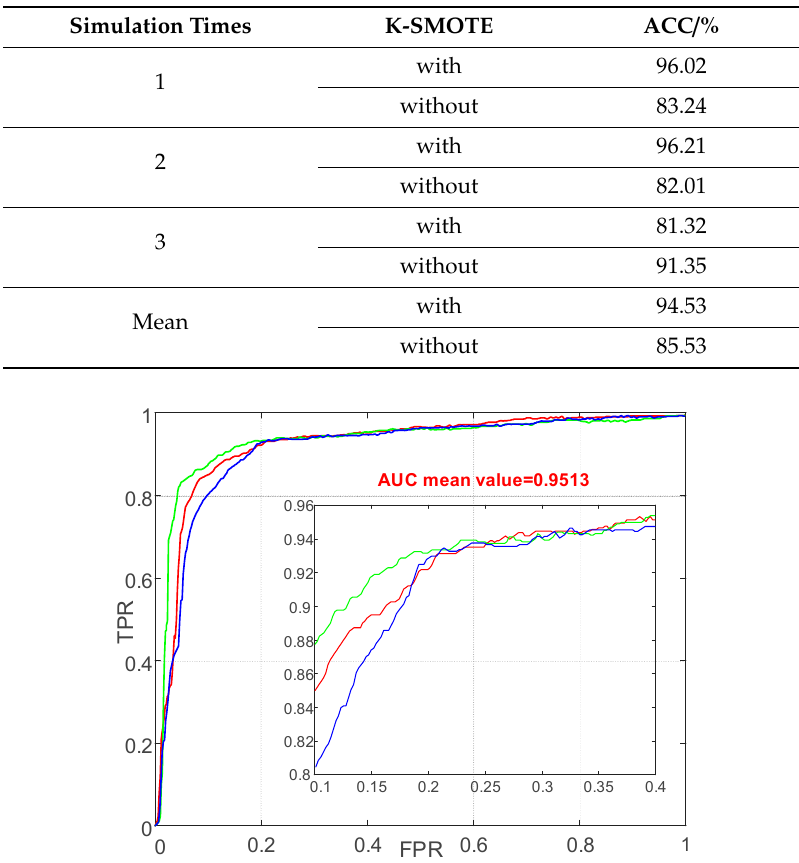
Figure 7. Receiver operating characteristic curve detected by RF with K-SMOTE.